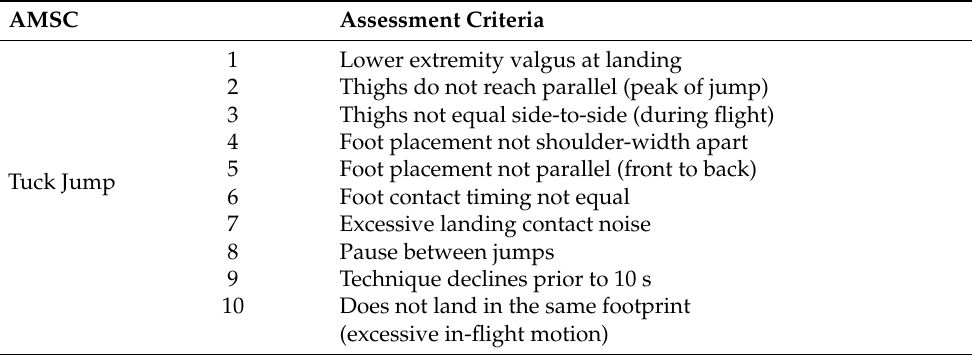
Table 3. Assessment criteria adapted from the Tuck Jump Assessment